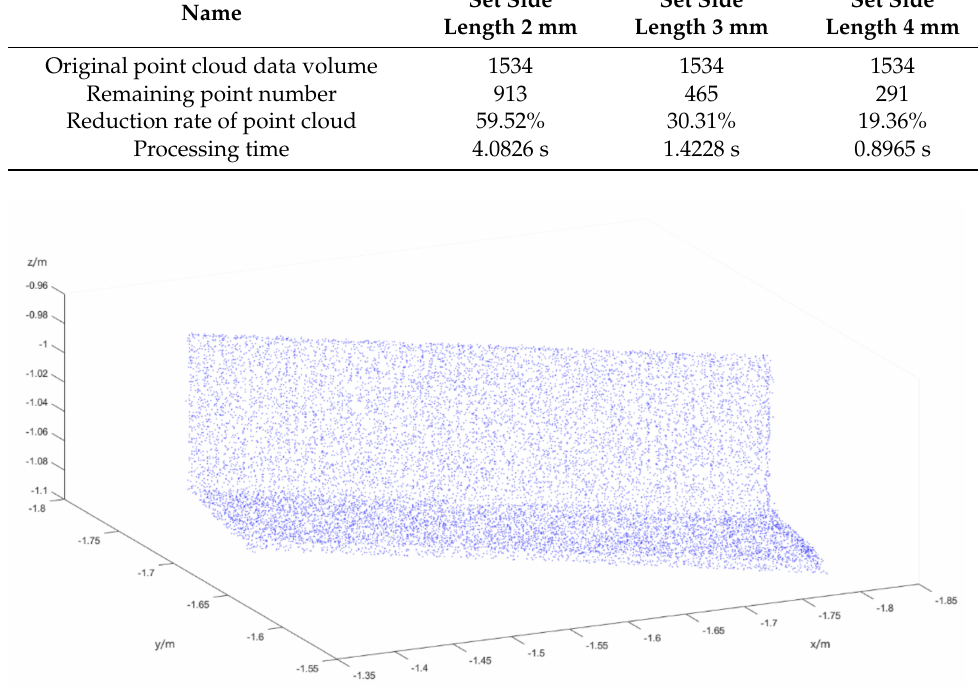
Figure 8. The effect of point cloud reduction after using this